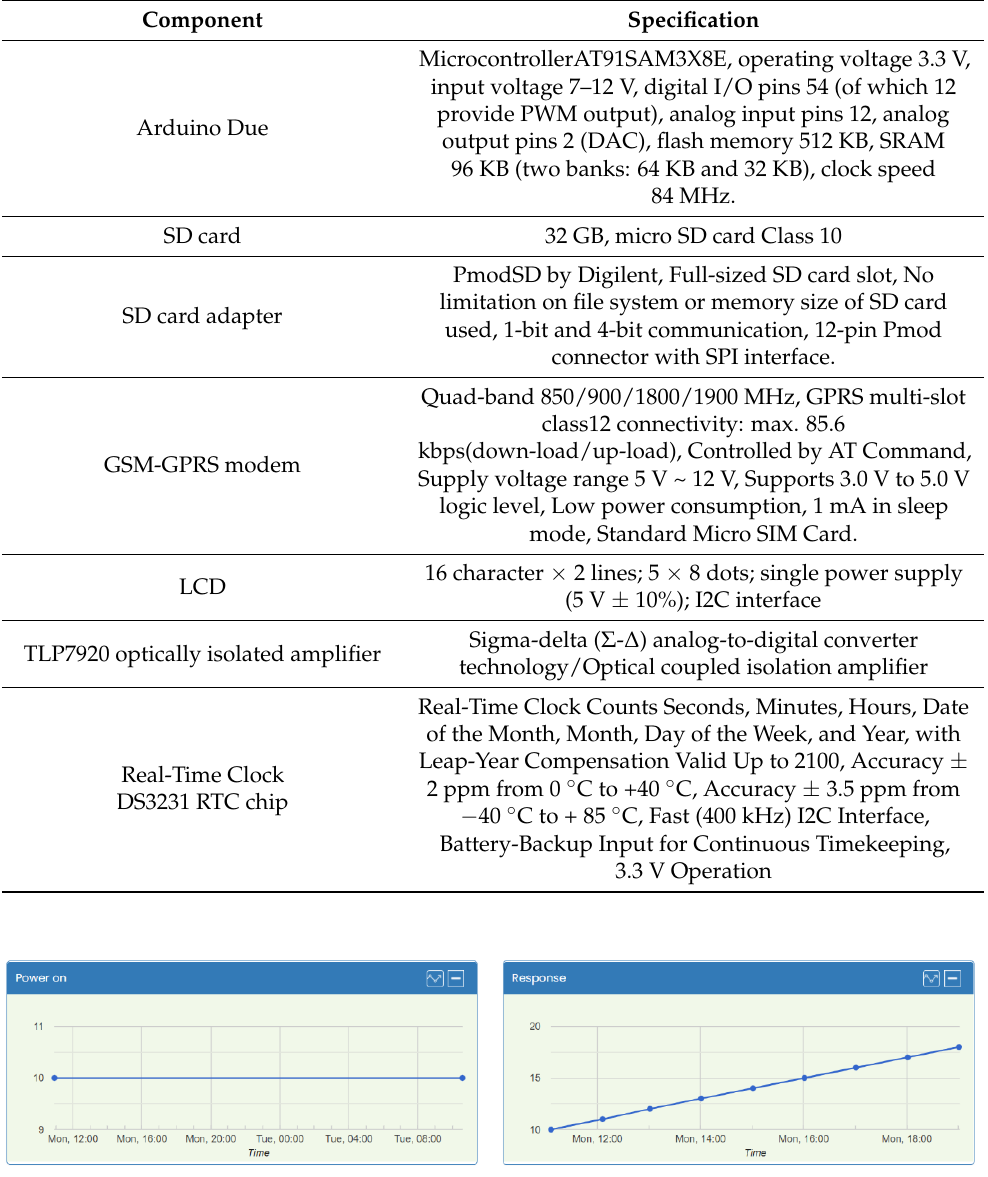
Table 4. Specification of components used for design of the prototype of DC motor overload detection system for excavator EKG-15.